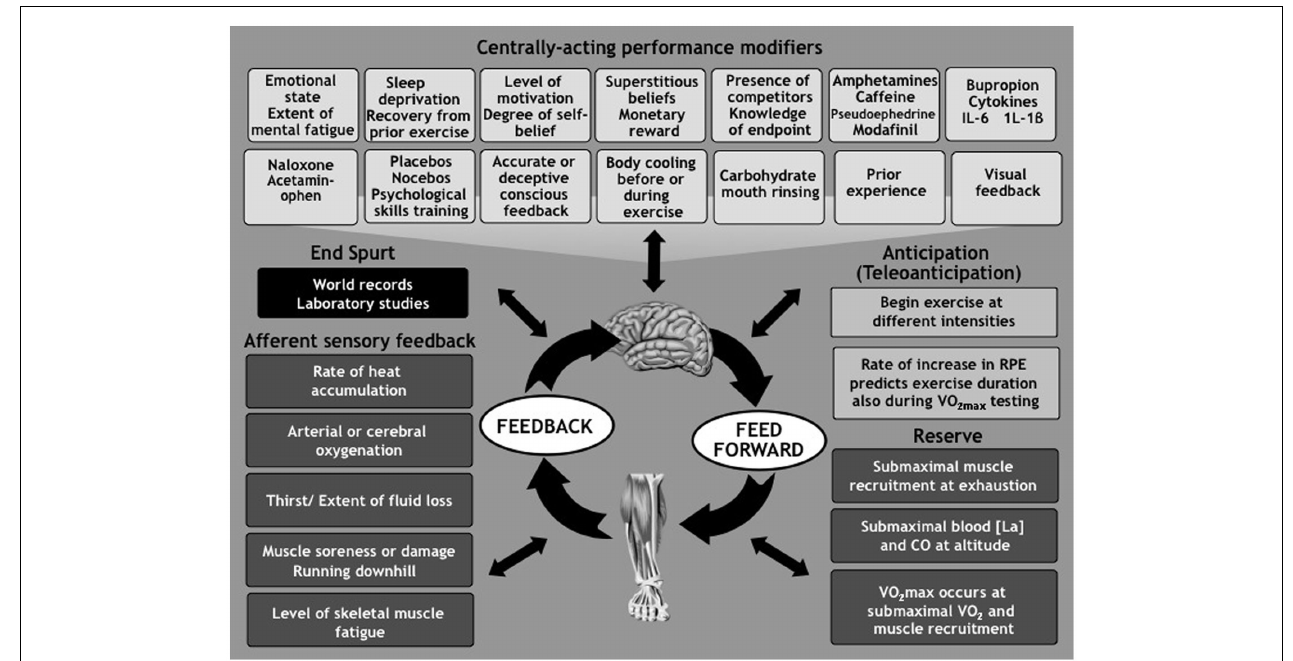
homeostasis.The brain uses the unpleasant (but illusory) sensations of fatigue to insure that the exercise intensity and duration are always within the exerciser’s physiological capacity.This model therefore predicts that the ultimate performances are achieved by athletes who best control the progression of these illusory symptoms during exercise. (For more details see St Clair Gibson et al., 2003; Noakes et al., 2004, 2005; St Clair Gibson